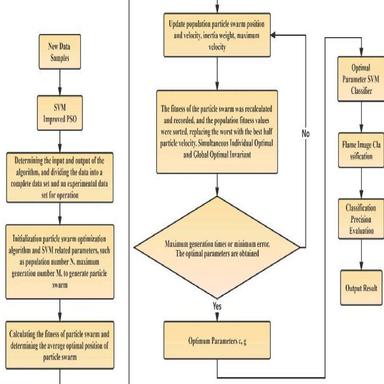
Flow chart of improved particle swarm optimization optimization algorithm based on nonlinear decreasing inertial weights.